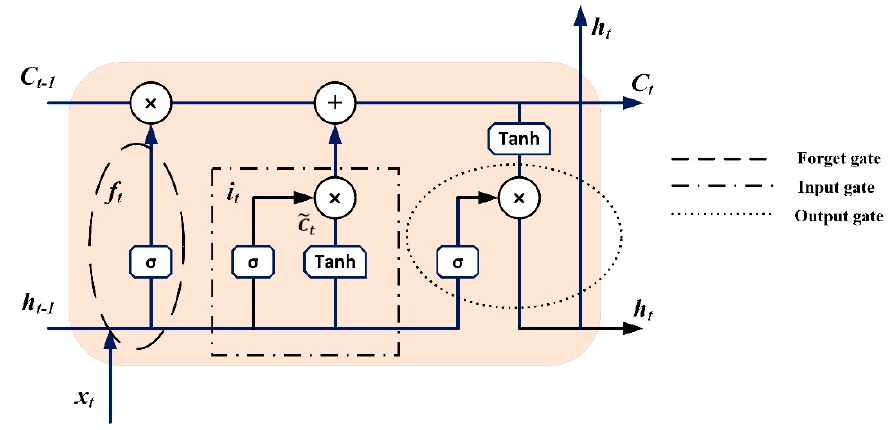
Figure 4. Graphical illustration of LSTM structures.